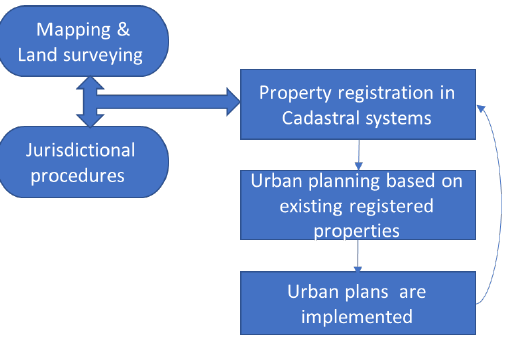
Figure 3. Iterative interaction between registration and planning.